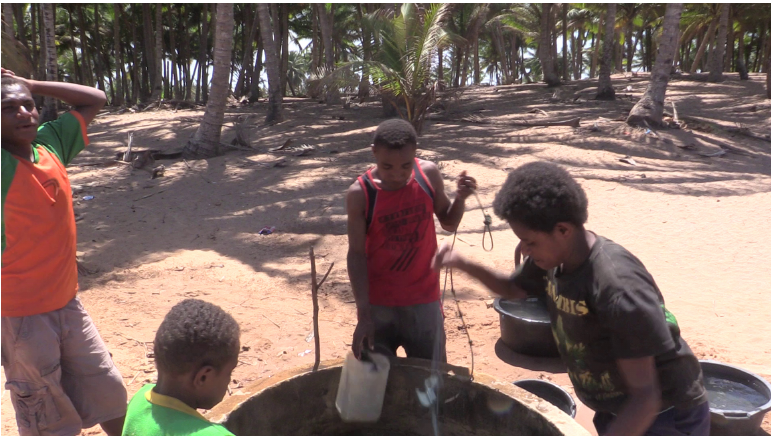
Figure 4: ‘There he’s coming, he’s bringing two.’; cf. example